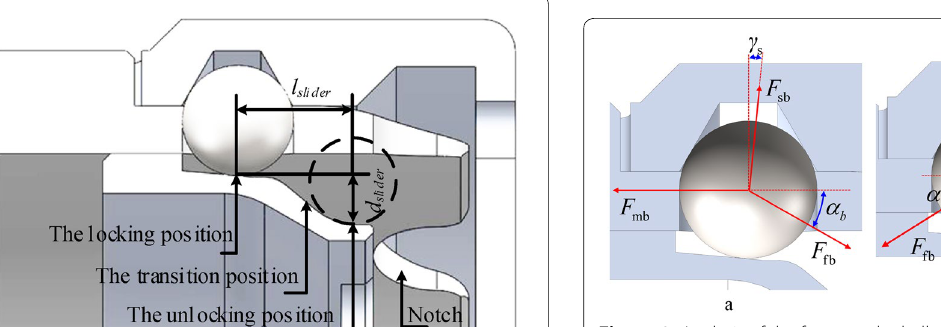
Figure 7 Slider design of the RCM based on SMA